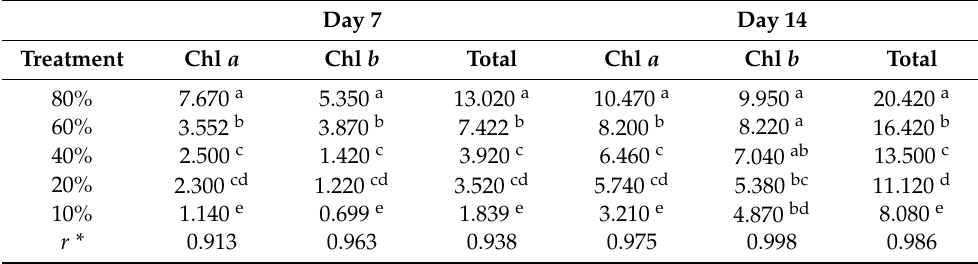
Table 3. Chlorophyll content (Chl a , Chl b , total chlorophyll) ( µ g/mL) of pea ( Pisum sativum L.) seedlings in response to soil water holding capacity levels: 80%, 60%, 40%, 20%, and 10% grown under continuous light at 25 ◦ C for 7 days and 14 days, separately. Means followed by different letters are significantly different ( p ≤ 0.05) by LSD; r = correlation